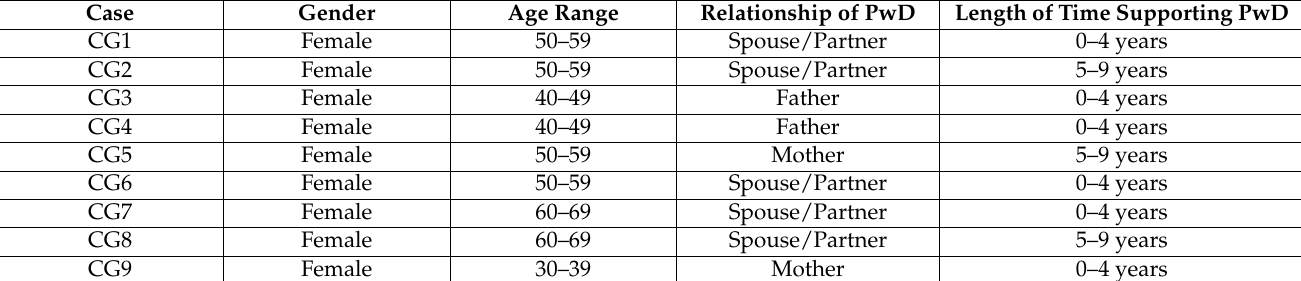
Table 3. Caregiver (CG) Demographic